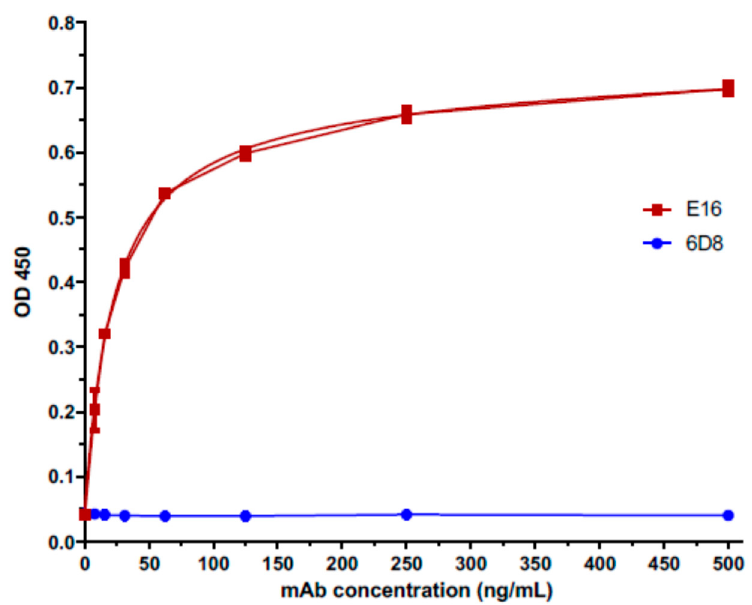
Figure 4. Specific binding of HBcAg-wDIII to a neutralizing mAb (E16) against WNV. Serial dilutions of the E16 mAb were incubated in microtiter plates coated with plant-produced HBcAg-wDIII and detected with an HRP-conjugated anti-human gamma antibody. A plant-produced anti-Ebola mAb (6D8) was used as a negative isotype control. Mean ± SD of samples from three independent experiments is presented.